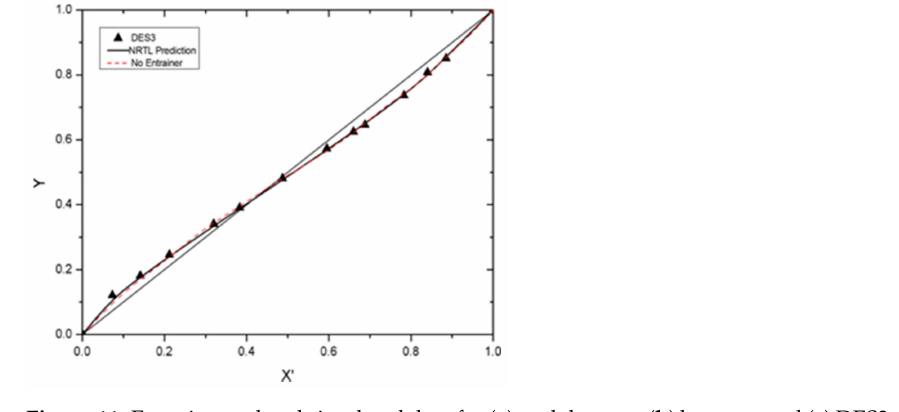
Figure 11. Experimental and simulated data for ( a ) cyclohexane, ( b ) benzene and ( c ) DES3 at 101.3 kPa for a DES molar fraction of 0.1.